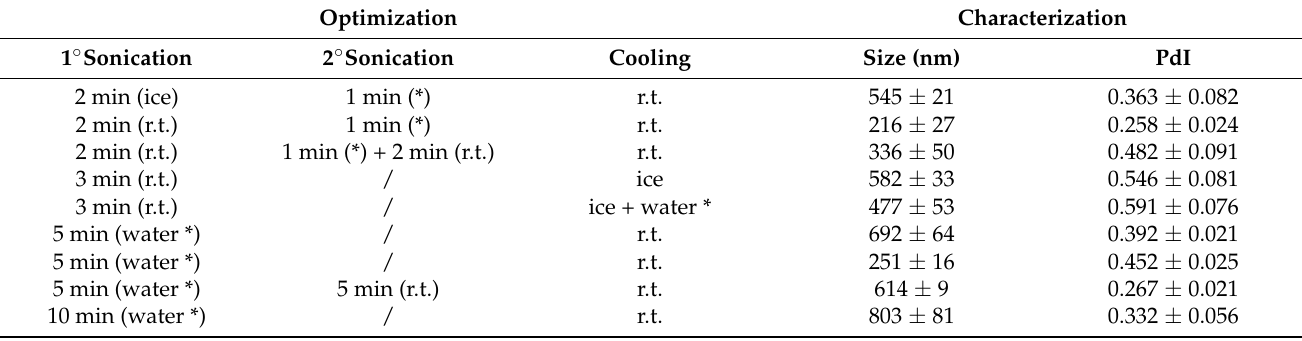
Table 1. Optimization of the emulsification-ultrasonication method and characterization by dynamic light scattering. Data are shown as the mean ± standard deviation ( n =